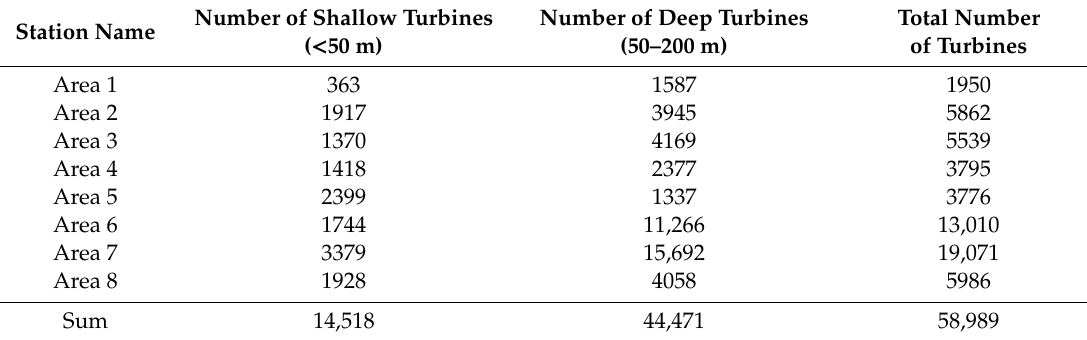
Table 3. Distribution of wind turbines in